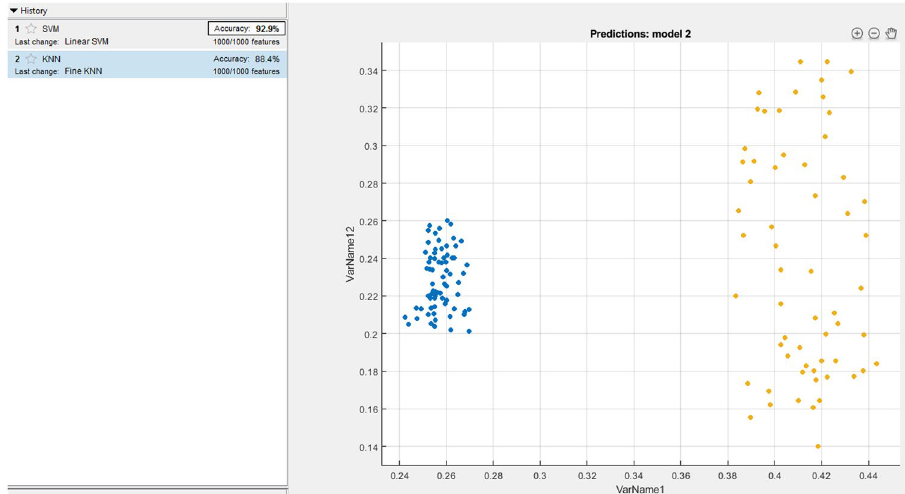
Figure 7. SVM and KNN analysis on QRS complex.